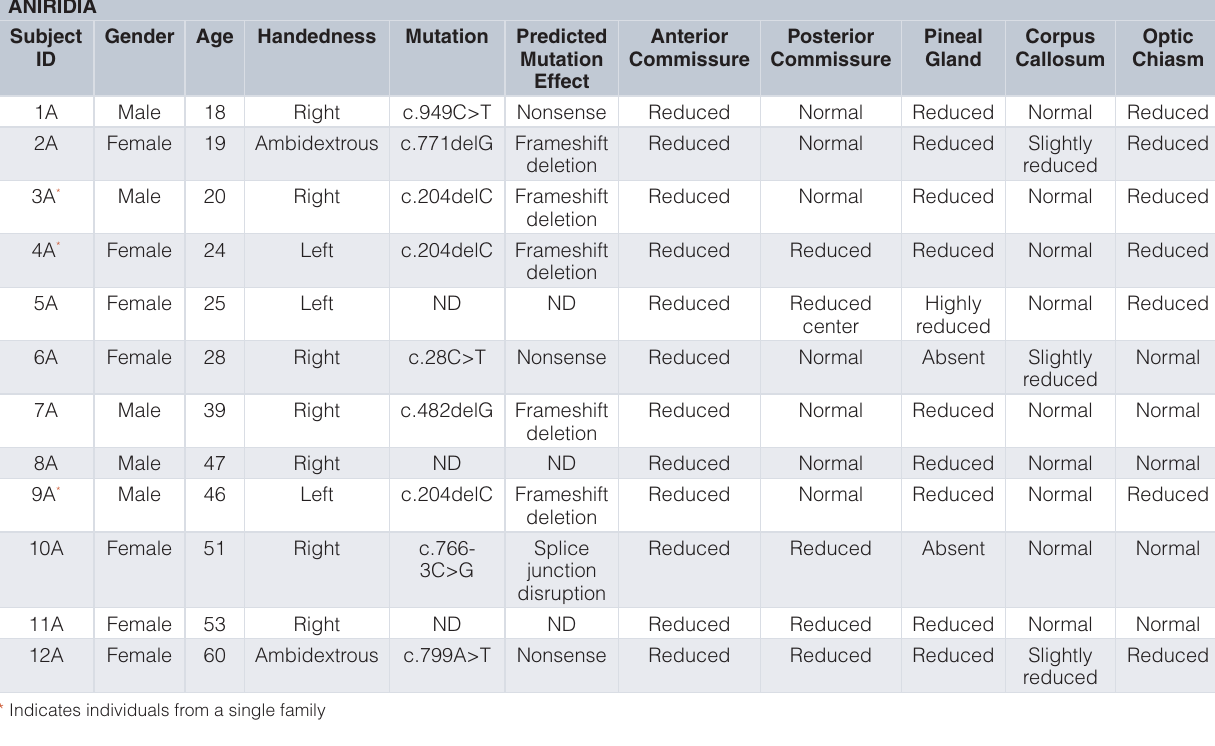
Table 1. ANIRIDIA. Subject demographics and structural abnormalities as seen in structural magnetic resonance images. Gender, age, handedness, mutation, and structural abnormalities of both aniridia subjects and healthy comparisons. Subject ID: Numbers are matched subjects, A refers to aniridia subjects, C refers to healthy comparisons. ND, not determined.